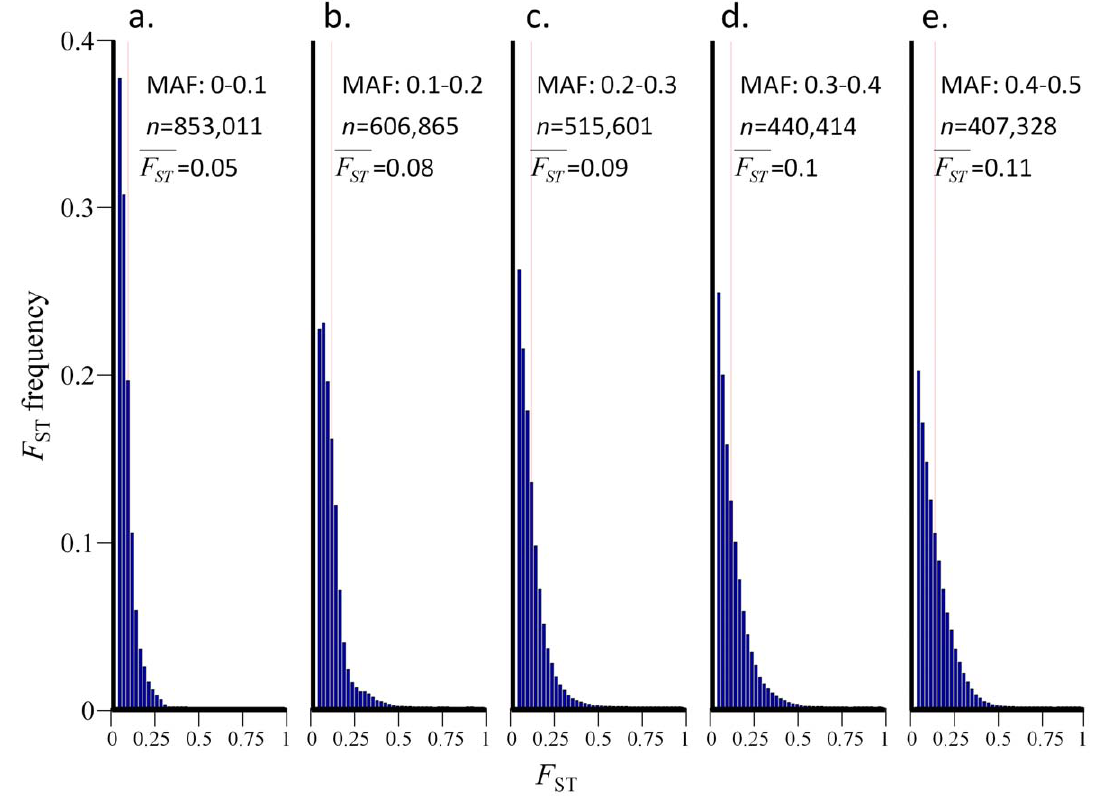
Figure 5. F ST distributions for five MAF groups (a–e). The histograms show the F ST values for five allele frequency groups divided by their MAF.